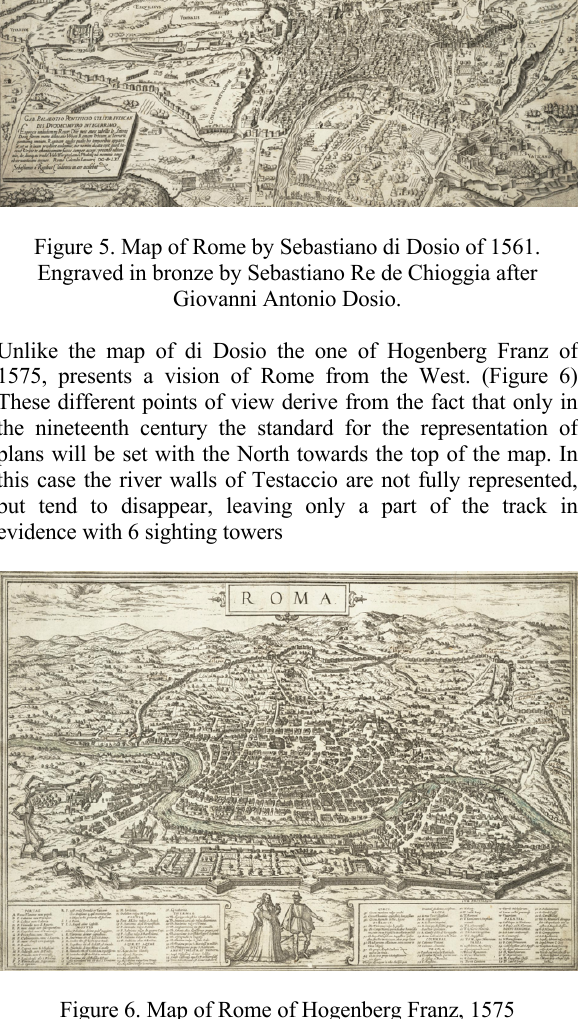
Figure 6. Map of Rome of Hogenberg Franz,